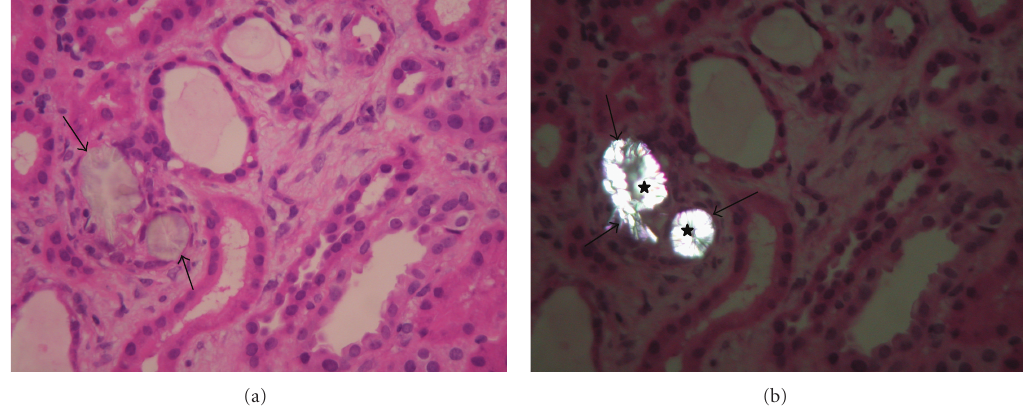
Figure 2: (a) Oxalate crystals (arrows) in tubular epithelium and lumena under normal light (Original magnification X400). (b) Calcium oxalate crystals ( (cid:2) ) in tubular epithelium and lumena under polarised light (Original magnification X400).